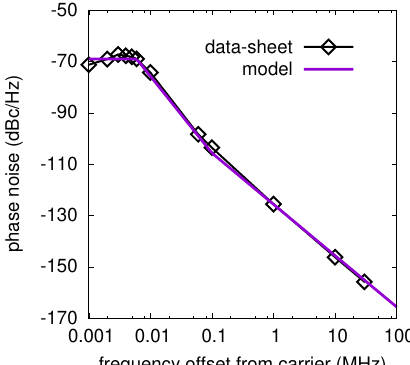
Figure 5. ADF5356 phase-noise: data-sheet vs model. The output frequency is 13.6 GHz (output B), the reference frequency to the phase-frequency detector (PFD) is 61.44 MHz and the loop filter has a 2 kHz bandwidth. The model parameters are: β = 1.25 × 10 − 7 s, f L = 6kHz and f C =